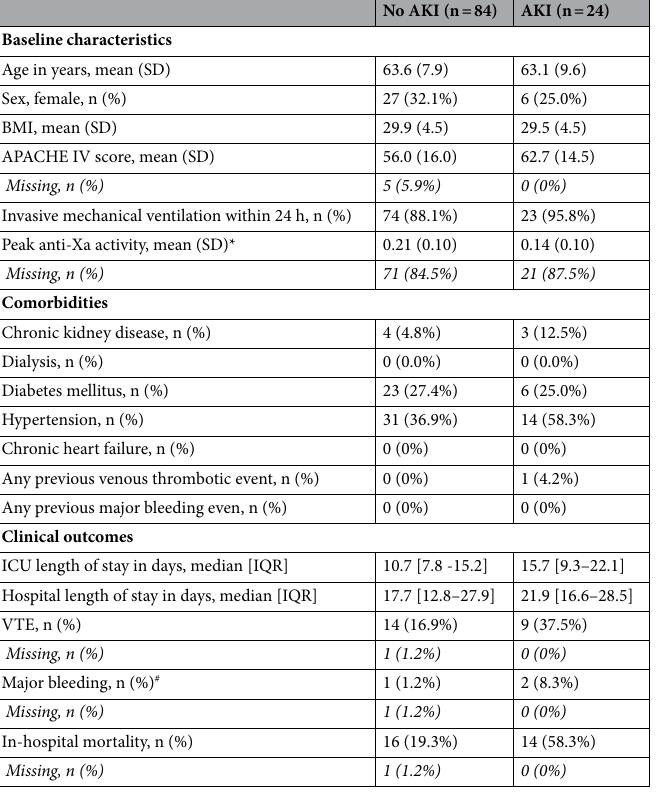
Table 1. Main analysis: characteristics and clinical outcomes. APACHE Acute physiology and chronic health evaluation, BMI body mass index, ICU Intensive care unit, IQR interquartile range, n number, SD standard deviation, VTE venous thromboembolism. *Calculation of mean peak anti-Xa activity was based on the highest peak anti-Xa measurement in 16 patients on intermediate dose nadroparin. # All bleeding events occurred after intermediate dose nadroparin had been converted to high dose nadroparin, for example for atrial fibrillation or VTE. Missing values are in